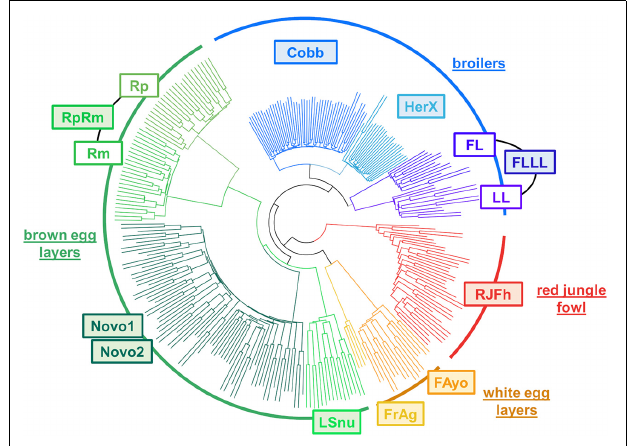
FIGURE 8 | Hierarchical clustering of 10 chicken populations using the 67,341 SNP intersection set with GT obtained using liver RNA-seq data. The hierarchical clustering was performed using the “snpgdsHCluster” from the package SNPRelate v1.8.0 (see also section “Materials and